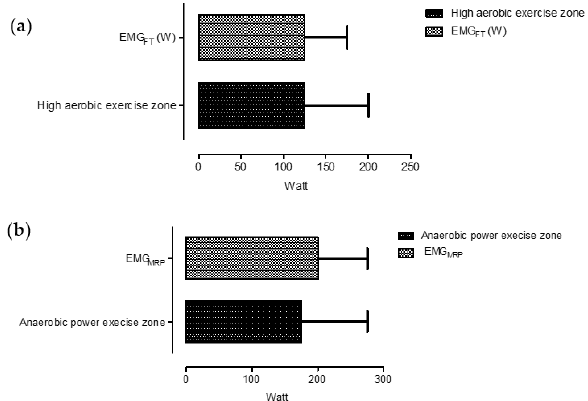
Figure 1. Illustration of the power output during high aerobic exercise zone, the fatigue threshold EMG FT point ( a ) and the electromyography maximum reached point (EMG MRP ) ( b ), presented as median value and range .